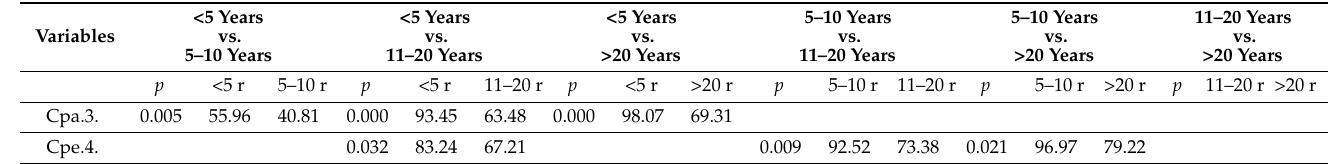
Table 7. Post hoc Kruskal-Wallis analysis according to the different age groups of teaching